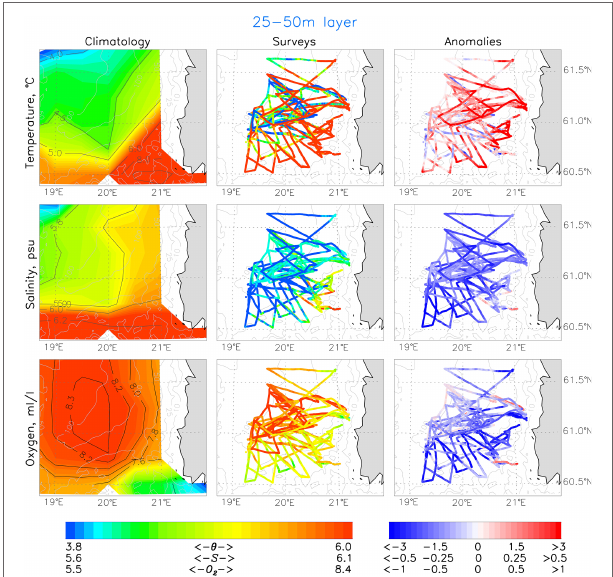
FIGURE 9 | Maps of 25-50m mean water temperature, salinity and dissolved oxygen from (left) July-October climatology, (middle) glider observations, and (right) anomalies computed as differences between glider observations minus climatology taken for the month corresponding to each individual glider